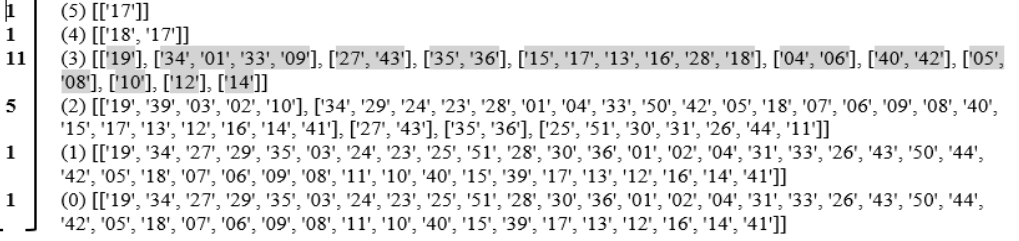
Figure 7. The q–connectivity lists and corresponding TU Q-vector. The left-hand column is the TU Q-vector i.e., number of components at each q-level, the number in the parentheses indicates the q-level, the square brackets indicate the connected components.